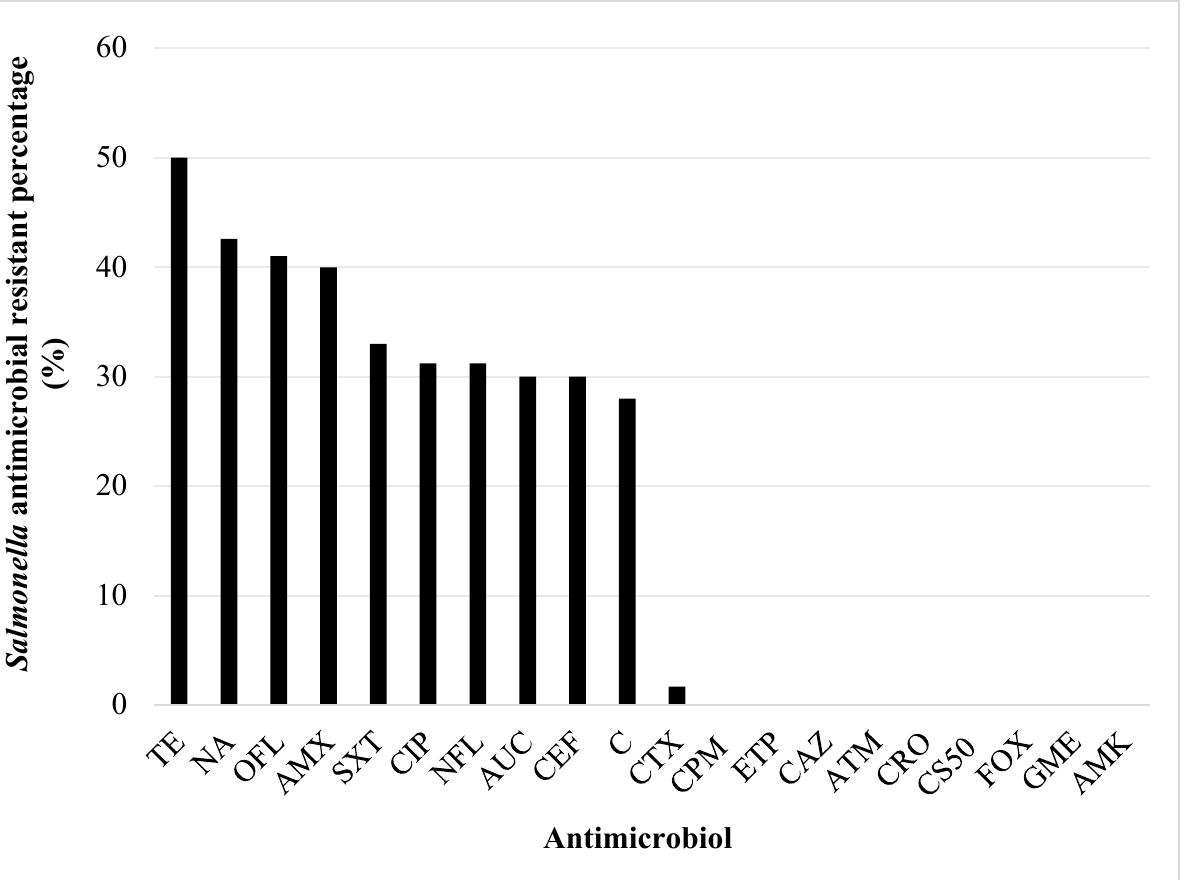
Figure 1. Antimicrobial-resistant percentages in Salmonella strains isolated from hospitalized patients with gastroenteritis in Great Tunisia between 2010 and 2020. AMX: Amoxicillin, AUC: Amoxicillin